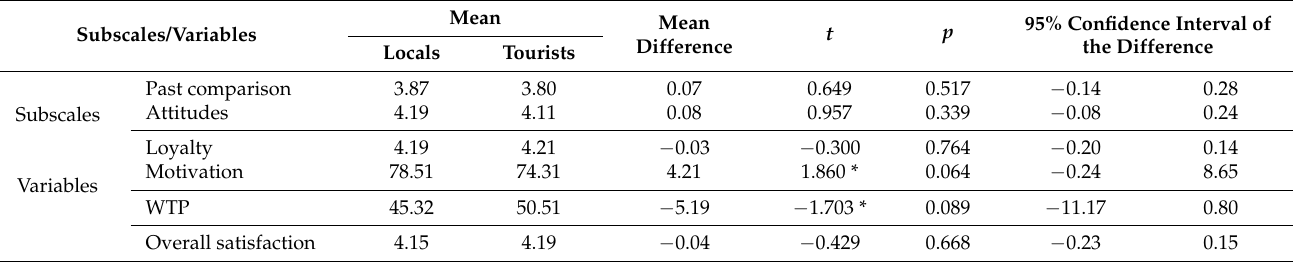
Table 4. t -Tests between locals and